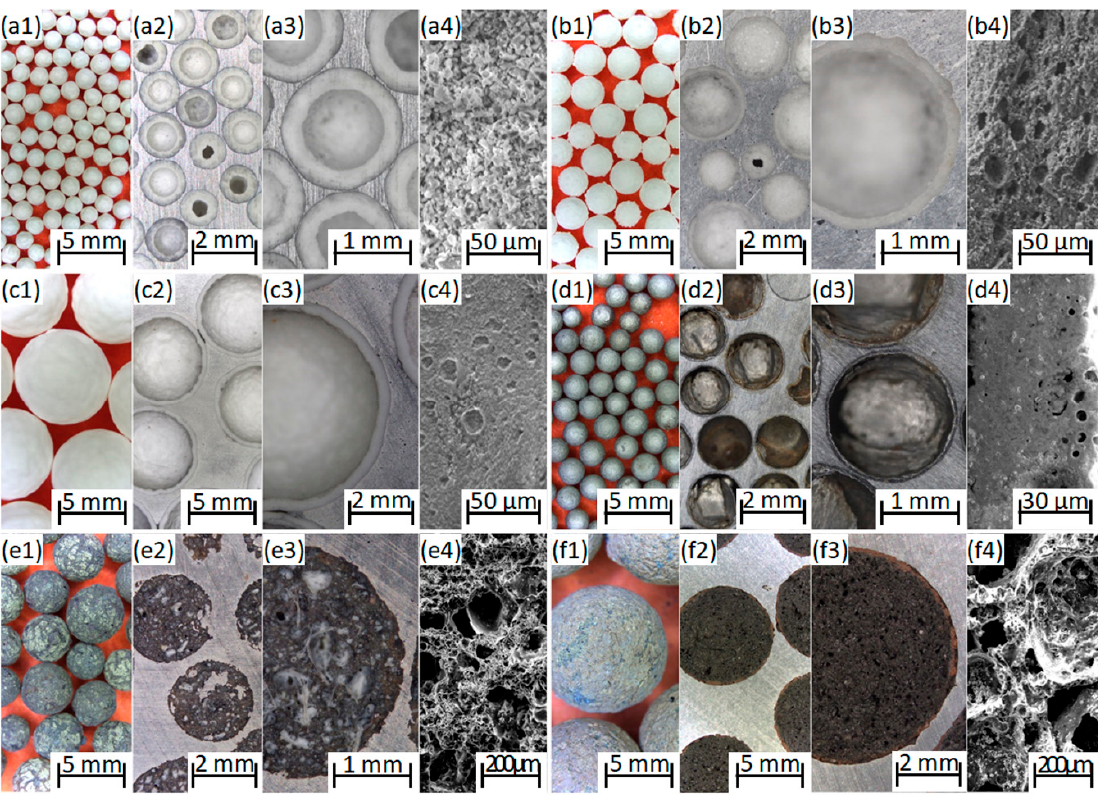
Figure 1. Geometrical features of the investigated fillers ( a ) CHS-1.6, ( b ) CHS-2.4, ( c ) CHS-7.0, ( d ) MHS, ( e ) LECAP-3.0 and ( f ) LECAP-9.0 along with the numberings of ( 1 ) macroscopic image of the sets of fillers, ( 2 ) low magnification image of the filler in AlSi12 matrix, ( 3 ) large magnification image of the filler in AlSi12 matrix and ( 4 ) scanning electron microscope (SEM) image of the fractured filler.